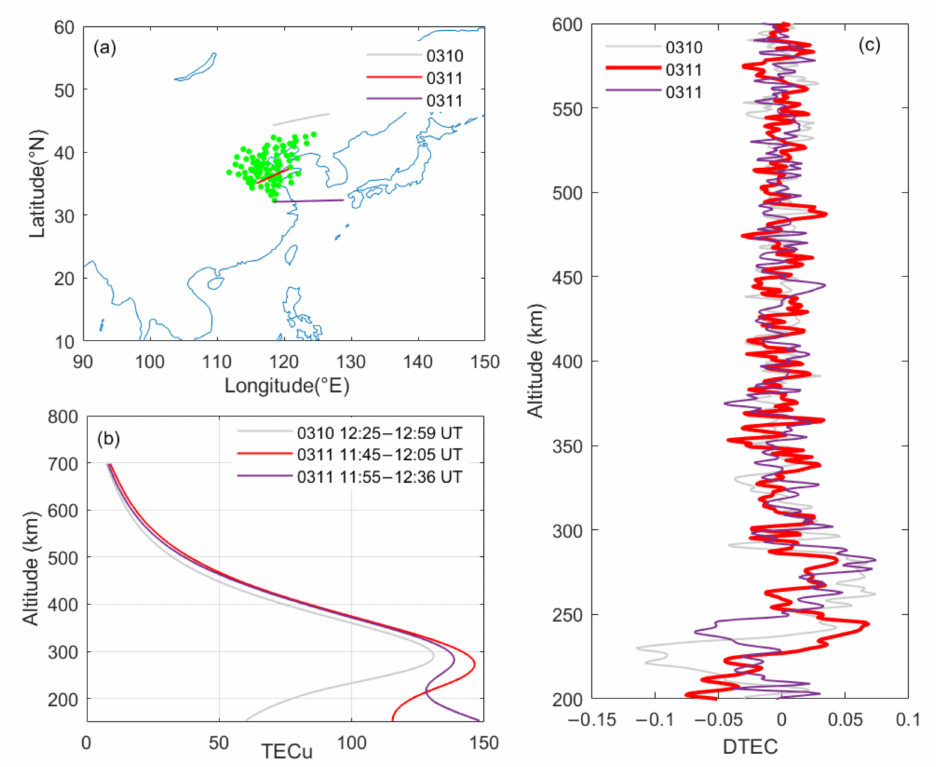
Figure 7. ( a ) Comparison of the total electron content (TEC) profiles observed before and near 12:00 UT around the ionosonde network. ( b ) The corresponding TEC profiles recorded by Constel- lation Observing System for Meteorology, Ionosphere, and Climate (COSMIC). ( c ) The detrended TEC